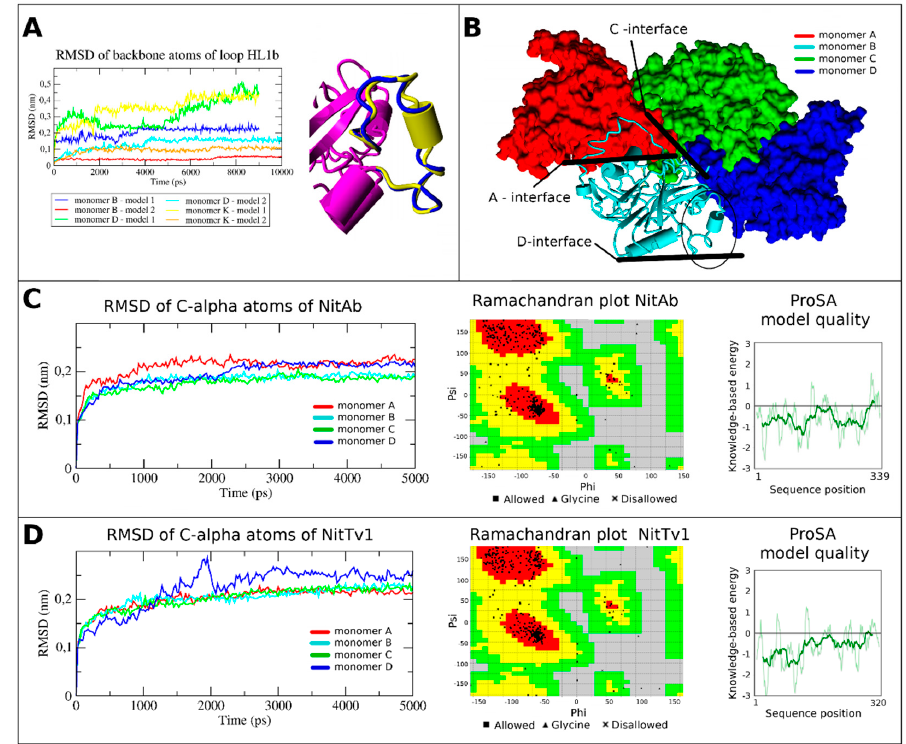
Figure A1. ( A ) Refinement of loop HL1b in NitAb. (Left) Root means square deviations (RMSD) of backbone atoms of loop HL1b (residues 82–110) during loop HL1b equilibration. (Right) Structural alignment of loop HL1b from model2 (monomer B) before refinement (blue) and after it (yellow); the rest of monomer B is colored magenta (right). ( B ) Model of NitAb tetramer. Monomers A (red), C (green) and D (blue) are represented by molecular surface, monomer B (cyan) by secondary structure in cartoon style. Interfaces between the monomers are marked with black lines; position of loop HL1b is marked with a black ellipse. ( C , D ) Analysis of model quality and refinement of NitAb (panel C) and NitTv1 (panel D) models. (Left) RMSD of C-alpha atoms of monomers during the complete model refinement. (Center) Ramachandran plot calculated for the most stable monomer B after refinement. (Right) The red, yellow, green and grey regions represent the favored, allowed, generously allowed and disallowed values, respectively, of the backbone phi-psi dihedral angles. Residues are marked in black. Smoothed ProSa-web plot of residue energies. Light green: energies averaged over 10 residues, dark green: energies averaged over 40 residues).